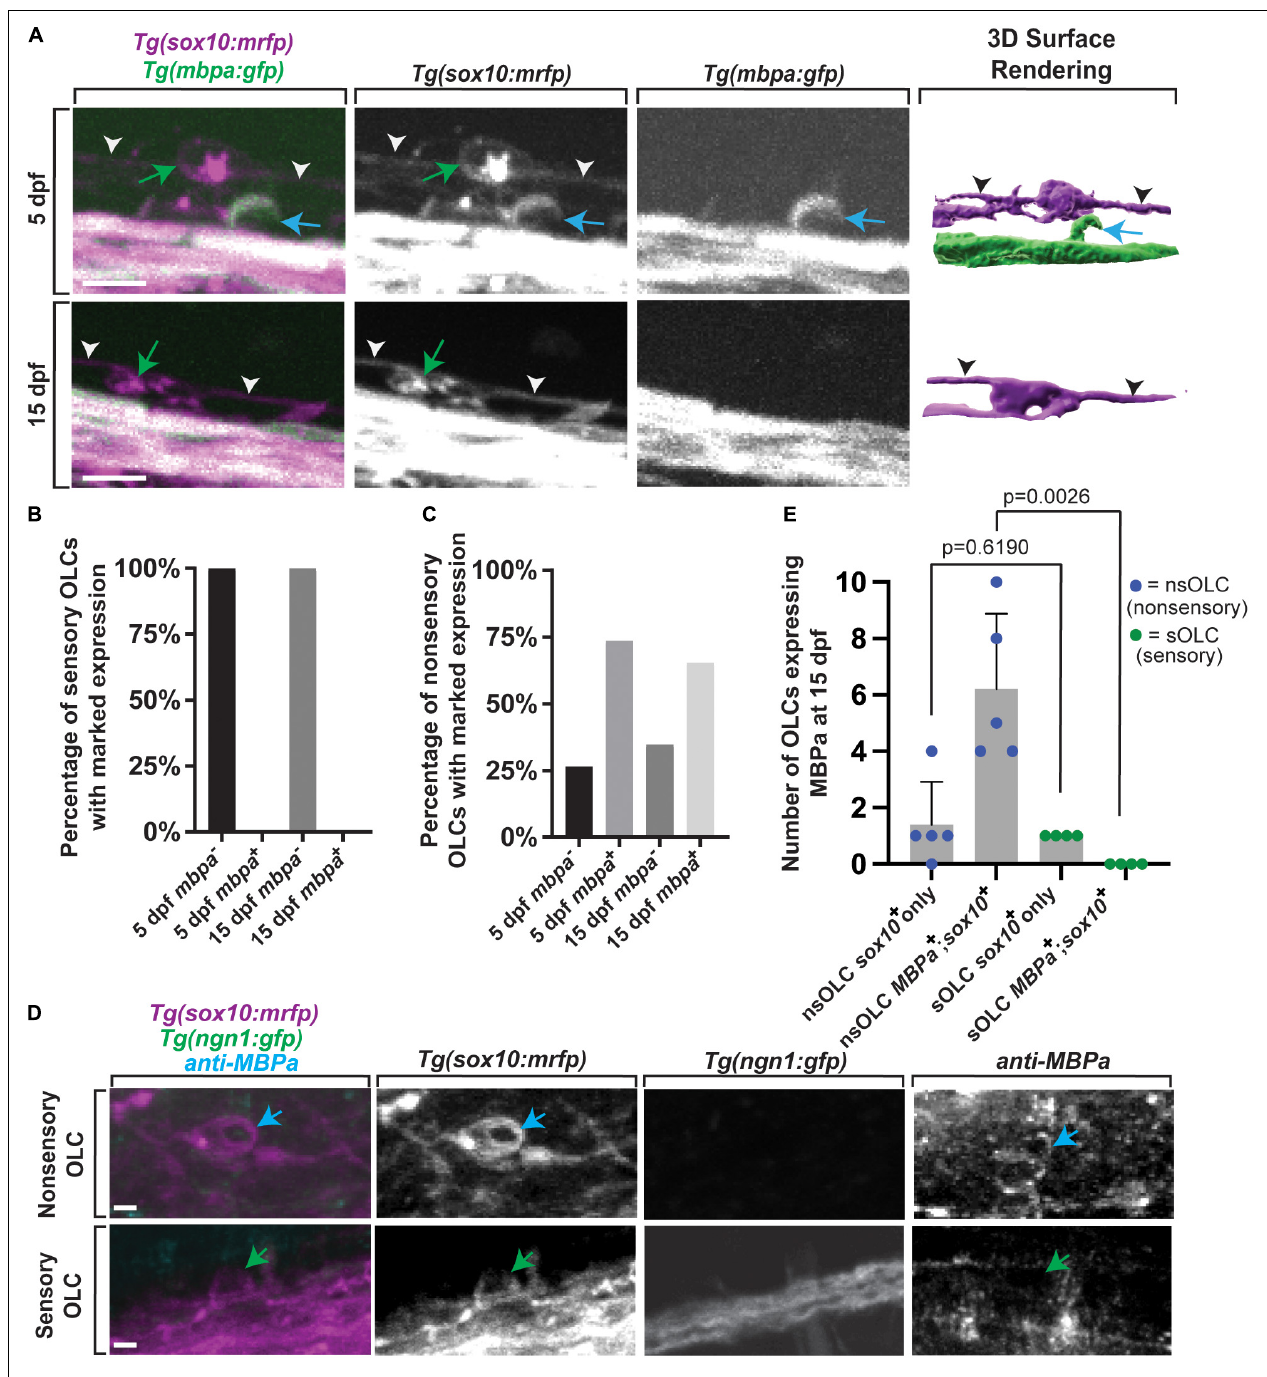
FIGURE 6 | Sensory-related OLCs do not express typical OLC mbpa expression. (A) Confocal z -stack still images of Tg(mbpa:gfp);Tg(sox10:mrfp) animals at 5 and 15 dpf showing the lack of mbpa + expression in sensory oligodendrocytes. Blue arrows represent non-sensory-related OLCs. Green arrows represent sensory-related OLCs. White and black arrowheads indicate sensory axons. (B) Quantification of the percentage of mbpa - ;sox10 + and mbpa + ;sox10 + sensory OLs at 5 and 15 dpf. (C) Quantification of the percentage of mbpa - ;sox10 + and mbpa + ;sox10 + non-sensory OLs at 5 and 15 dpf. (D) Confocal z -stack still images of Tg(sox10:mrfp);Tg(ngn1:gfp) animals at 15 dpf stained with an anti-MBPa antibody showing the lack of anti-MBPa in sensory-related OLCs. Blue arrows represent non-sensory-related OLCs and green arrows represent sensory-related OLCs. (E) Quantification of the number of non-sensory-related OLCs (nsOLCs) and sensory-related OLCs (sOLCs) expressing sox10 + only or at 15 dpf. Scale bar equals 10 µ m (A,E) . All images are orientated anterior to left, posterior to right, dorsal up and ventral down.